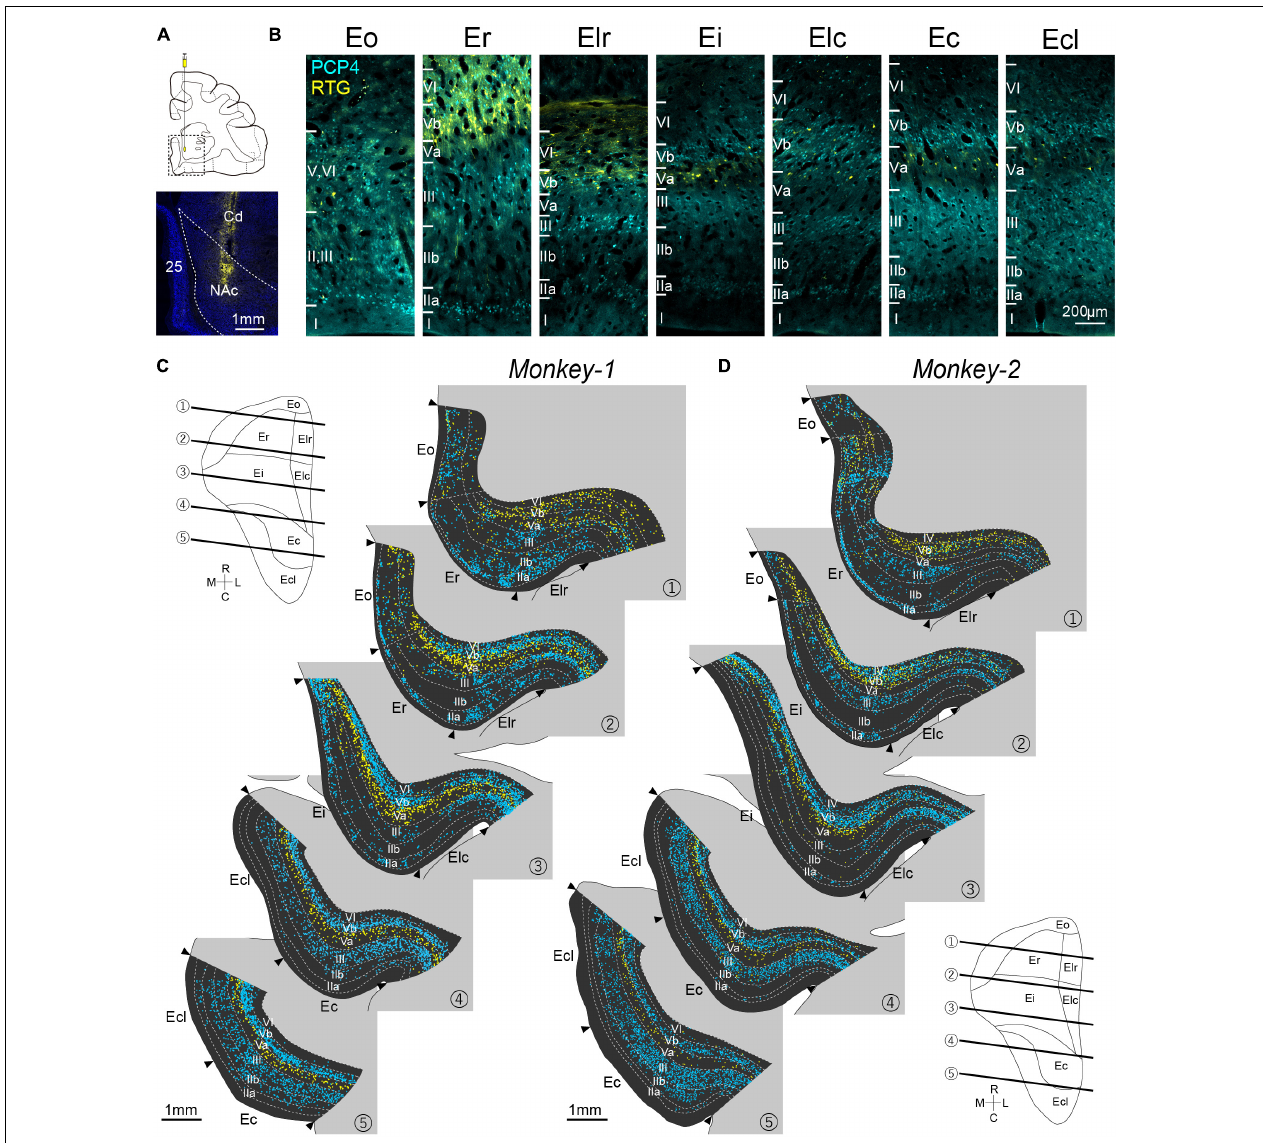
FIGURE 2 | Distribution of PCP4 + neurons and NAc-projecting neurons in monkey EC. (A) Injection site of the retrograde AAV in the NAc. 25: area 25; Cd: Caudate. (B) Fluorescent micrographs of retrogradely labeled (RTG + ) NAc-projecting neurons (yellow) and PCP4 + neurons (cyan) in EC subdivisions. (C,D) Series of coronal sections of EC showing the distribution of NAc-projecting neurons (yellow plot) and PCP4 + neurons (cyan plot) in Monkey-1 (C) and Monkey-2 (D) . NeuN-labeling was used to delineate the individual layers and the EC subdivision. The approximate rostrocaudal levels of the sections are indicated in the unfolded map of EC.